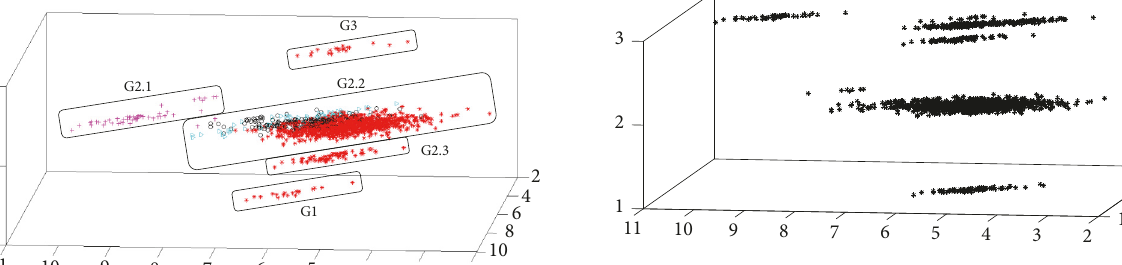
Figure 9: CMLHL + partitional